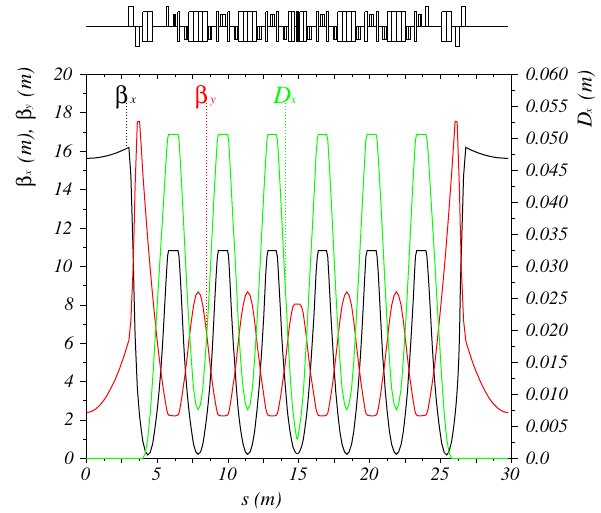
FIG. 14. Optical functions of SKIF super period ( 1 = 16 th of the ring), beginning and ending at the center of the straight section.